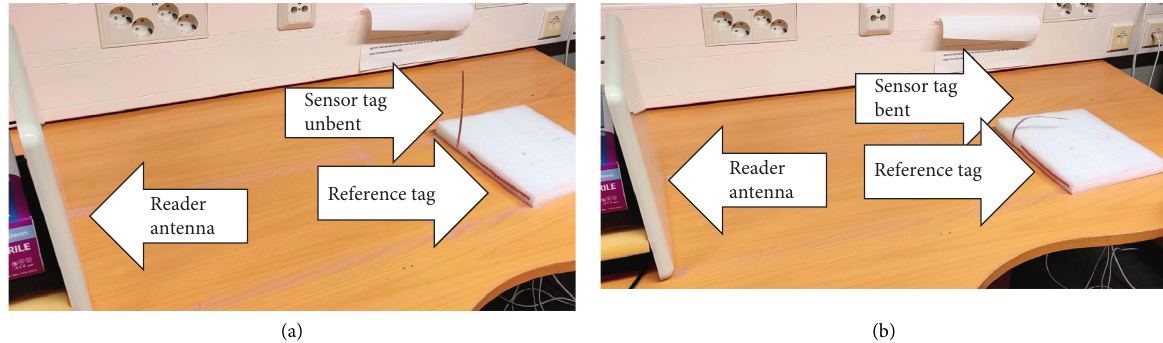
Figure 5: Arrangement of the sensor tag and reference tag test: unbent sensor tag (a) and bent sensor tag (b).